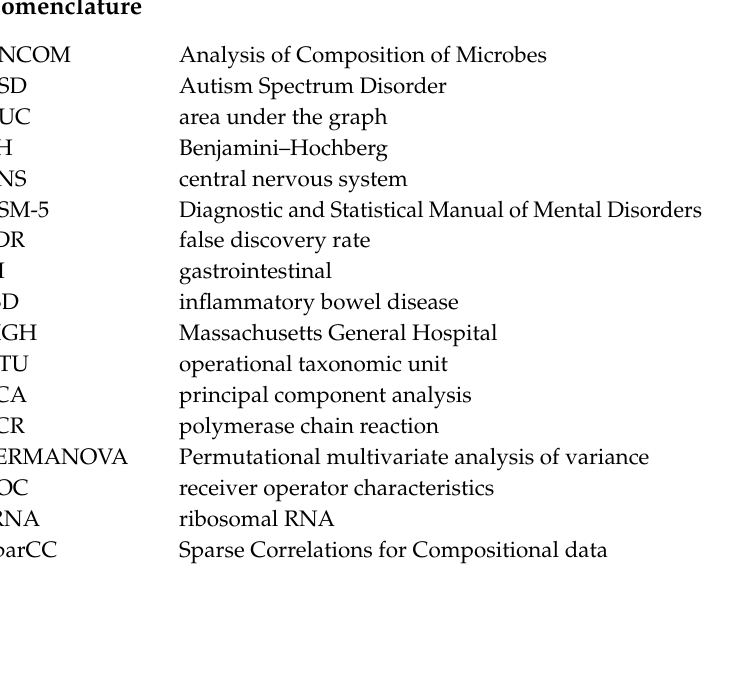
and Proteobacteria co-occurrence cluster identified from SparCC co-occurrence analysis. Figure S7. Gut and oral microbiome genus level SparCC co-occurrence network (Corr > 0.3 and Corr > 0.7). Figure S8. Correlation between gut and oral alpha diversity (Shannon index). Table S1. Metadata, subject characteristics and clinical indices. Table S2. Salivary and gut phylum and genus level OTU table. (XLS, 195KB). Table S3. Salivary and gut alpha Diversity raw data and statistics (Kruskal–Wallis test). Table S4. Statistics of beta diversity indices (PERMANOVA). Table S5. Stool and saliva phylum and genus level di ff erential relative abundances (group means, p values, FDR adjustment with BH method, Kruskal–Wallis test). Table S6. Saliva and gut genus level paired Wilcoxon test, ASD vs. Control subjects (Wilcoxon’s F statistic, p values, FDR adjustment with BH method, Paired Wilcoxon’s test). Table S7: Di ff erential abundances by ANCOM (ASD: saliva vs. stool, Control: saliva vs. stool, Saliva: ASD vs. Control, Stool: ASD vs. control). Table S8: ROC curve AUC and test statistics for significant biomarkers that distinguish ASD and control groups. Table S9: Saliva and stool genus level relative abundances based on allergy status using genera with at least 0.5% mean relative abundances (group means, p values, FDR adjustment with BH method, Kruskal–Wallis test). Table S10: Saliva and stool genus level relative abundances based on abdominal pain status using genera with at least 0.5% mean relative abundances (group means, p values, FDR adjustment with BH method, Kruskal–Wallis